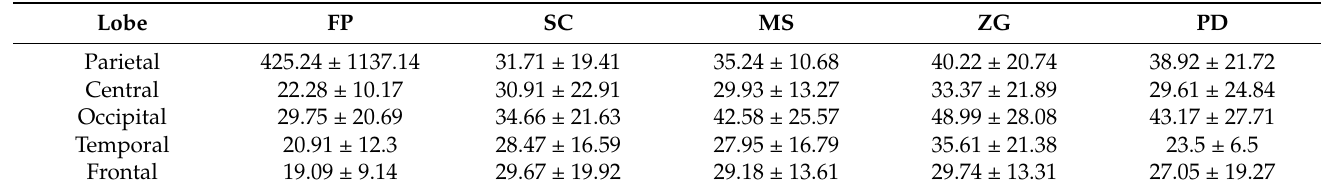
Table 6. Average results by cerebral lobes of the beta band absolute power (µV2/Hz) for the signals of the games Finger Painting (FP), Sorting Cubes (SC), More Switches (MS), Zero Gravity Switches (ZG), and Punch the Dummy (PD).